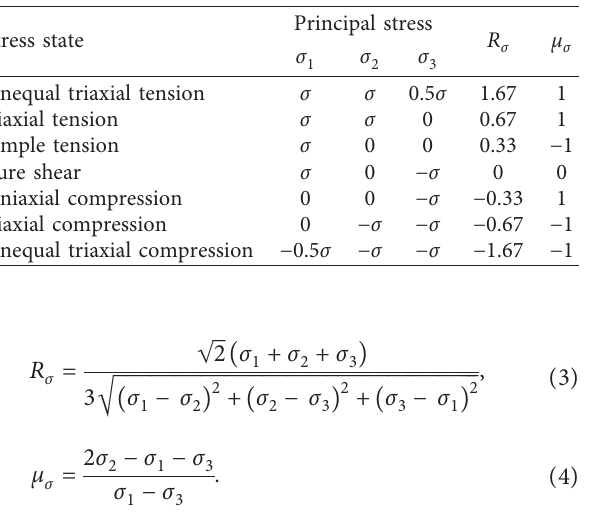
and μ under different stress σ σ